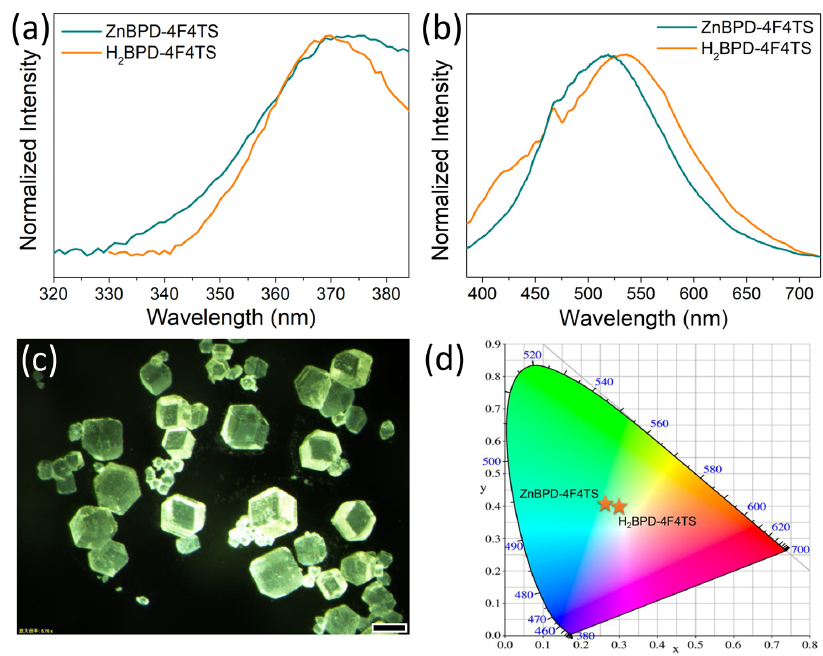
Figure 3. ( a ) Excitation spectra of ligand H 2 BPD-4F4TS ( λ em = 535 nm) and ZnBPD-4F4TS ( λ em = 518 nm) in the solid state. ( b ) Emission spectra of ligand H 2 BPD-4F4TS and ZnBPD-4F4TS when excited at 370 nm UV light in the solid state. ( c ) A photograph of as-synthesized ZnBPD-4F4TS single crystals under UV light irradiation. The scale in the figure is 100 µ m. ( d ) CIE chromaticity diagram of ligand H 2 BPD-4F4TS and ZnBPD-4F4TS when excited at 370 nm.